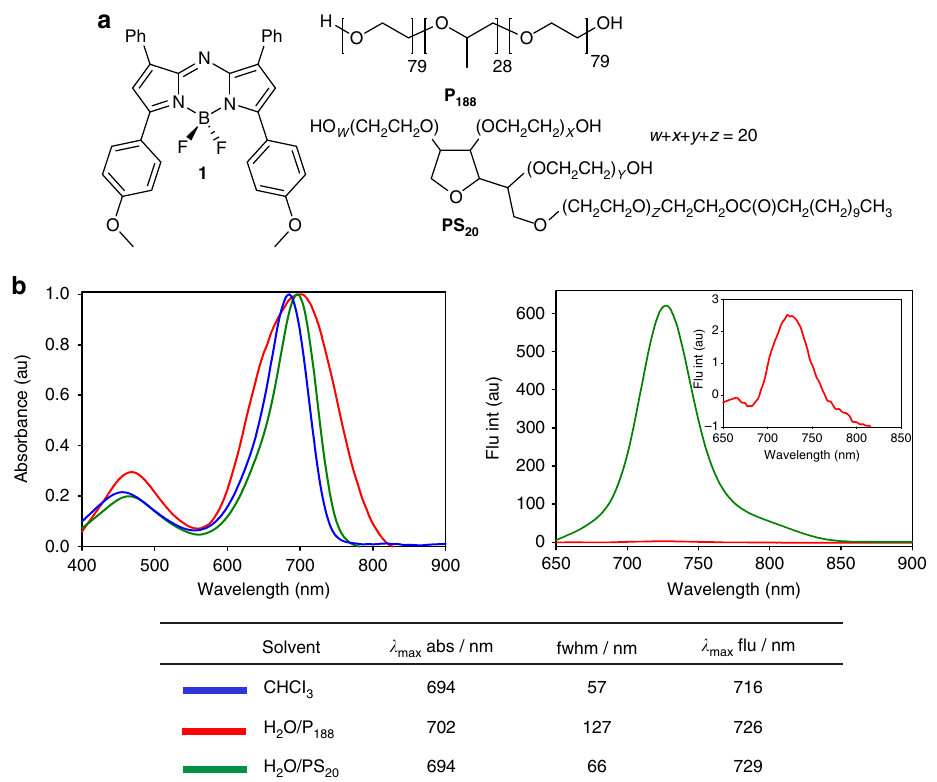
Fig. 2 Spectral evidence of a DSA using a hydrophobic fl uorophore and P 188 . a Structures of NIR-AZA 1 , P 188 and PS 20 . b Absorbance spectra, emission spectra and photophysical parameters of 1 in CHCl 3 (blue), H 2 O/P 188 (red) and H 2 O/PS 20 (green). 5 µ M 1 ; 1.19 mM P 188 ; 8.14 mM PS